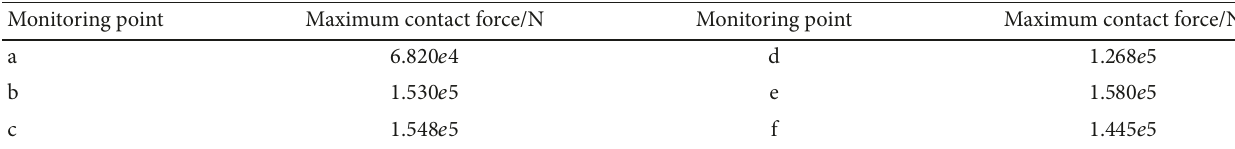
Table 4: Maximum contact force in the specimen at different monitoring points. Monitoring